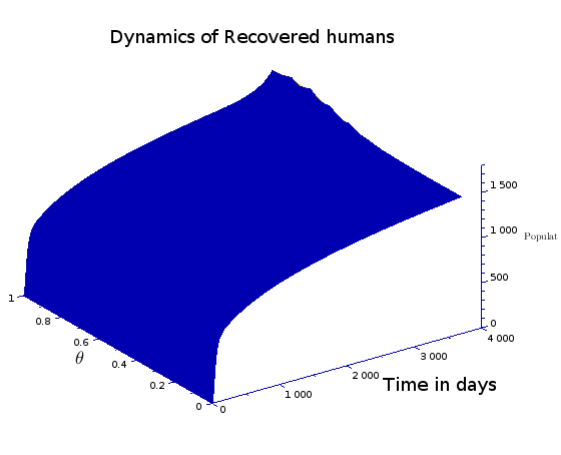
Fig. 2: The number of recovered individuals ( e = 1 , g ( t , θ ) = ( 1 − 0.2466 ) γ ( t , θ )) 59 ∗ 365